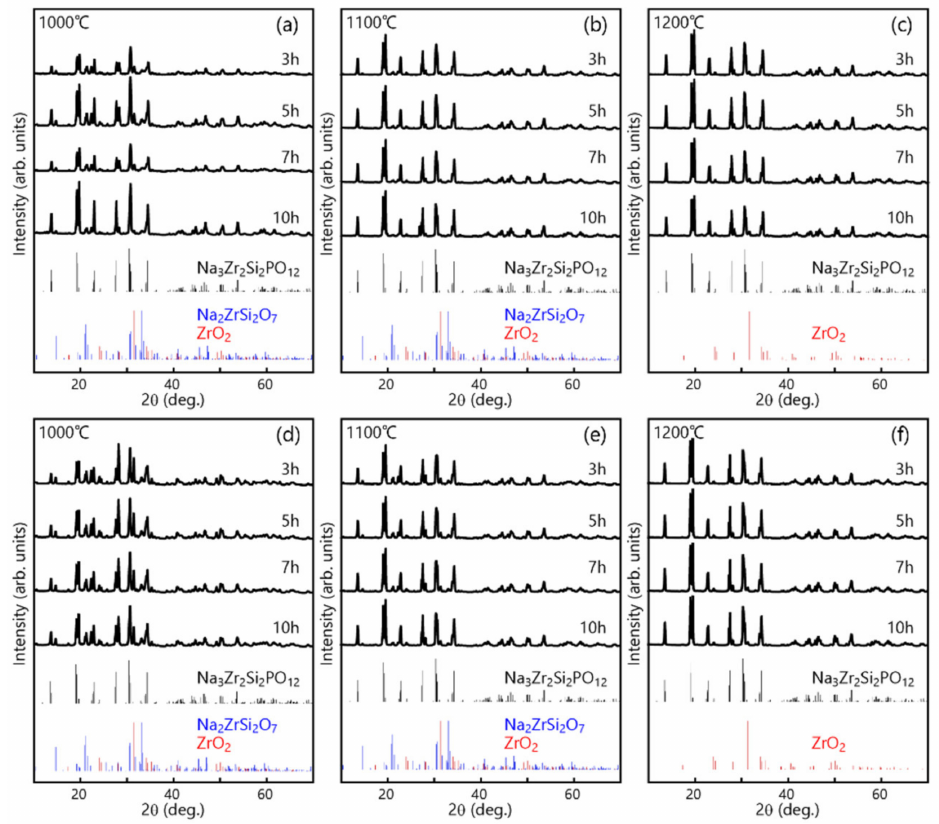
Figure 2. XRD patterns of the LPS-NZSP ( a – c ) and SSR-NZSP ( d – f ) calcined at various temperature. The refined XRD pattern of the LPS-NZSP calcined at 1000 ◦ C for 10 h shows in Figure 3. The content of the NZSP, Na 2 ZrSi 2 O 7 , and ZrO 2 were analyzed by PROFEX